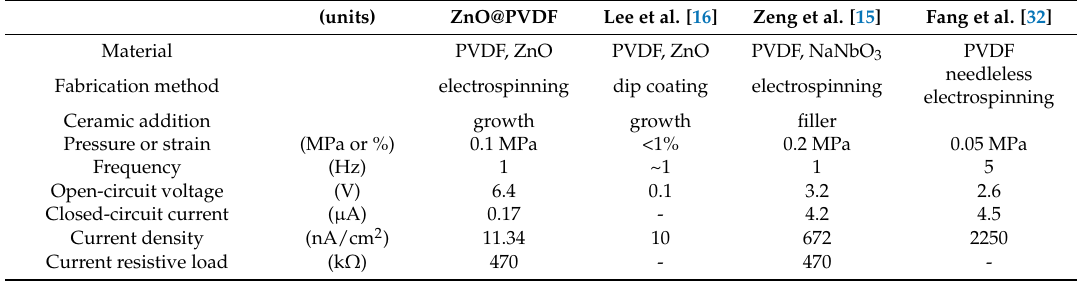
Table 4. Performance comparison of ZnO@PVDF with conductive knitted fabric electrodes to other works of flexible and breathable